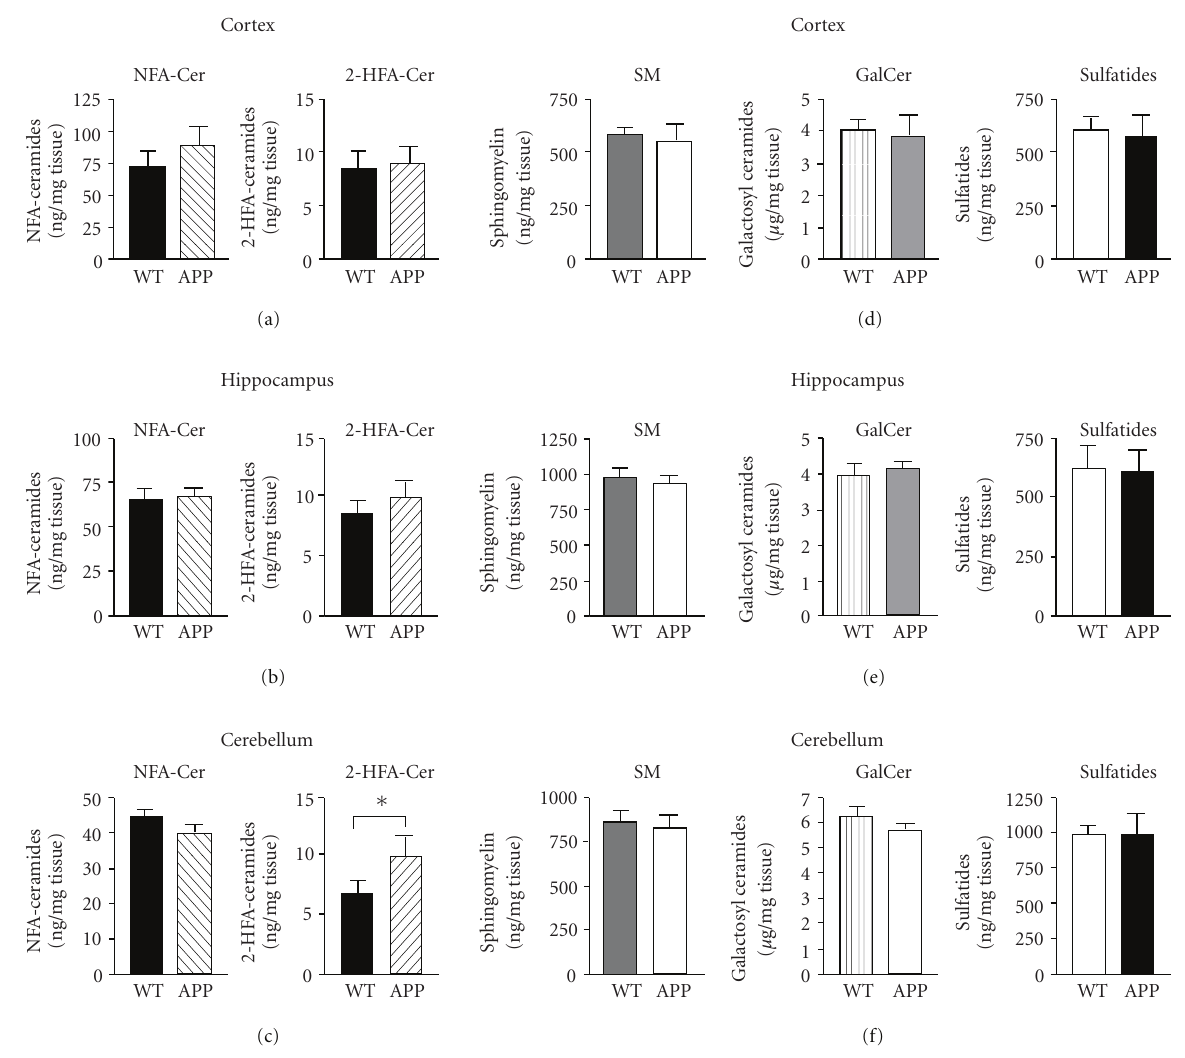
Figure 1: Levels of NFA-ceramides and 2-HFA-ceramides (a–c) and other related-sphingolipids (SM, GalCer, and sulfatides) (d–f) in the cortex, hippocampus, and cerebellum of 24-month-old APP SL mice and age-matched nontransgenic mice. WT: wild-type control mice. Each sphingolipid class was analyzed by HPTLC and their respective concentrations were calculated from standard curves after densitometric scanning of the plates as described under Section 2. Values are expressed as the means ± S.D. and statistically analyzed by a Mann-Whitney test. ∗ P < . 05 compared to the respective wild-type